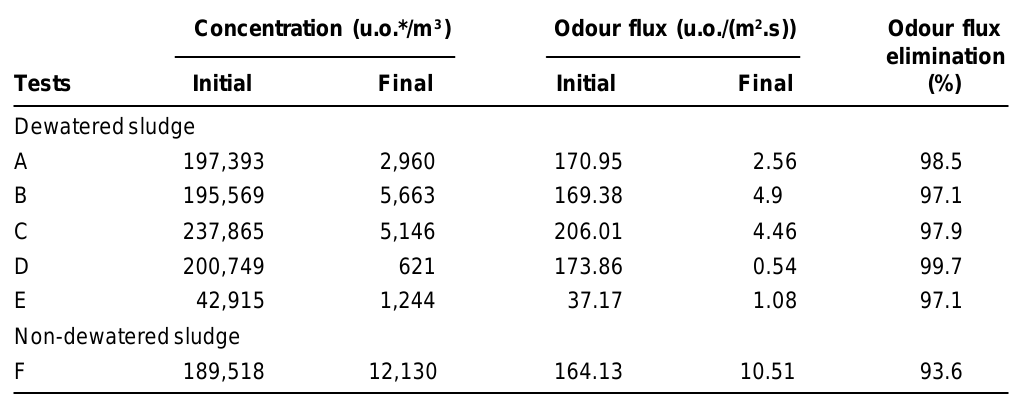
Odour Elimination Measurements During the Sludge